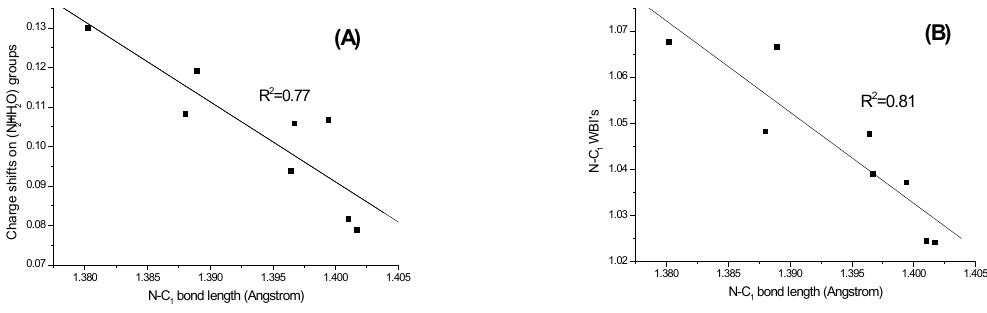
Figure 6. Various correlations among the N-C